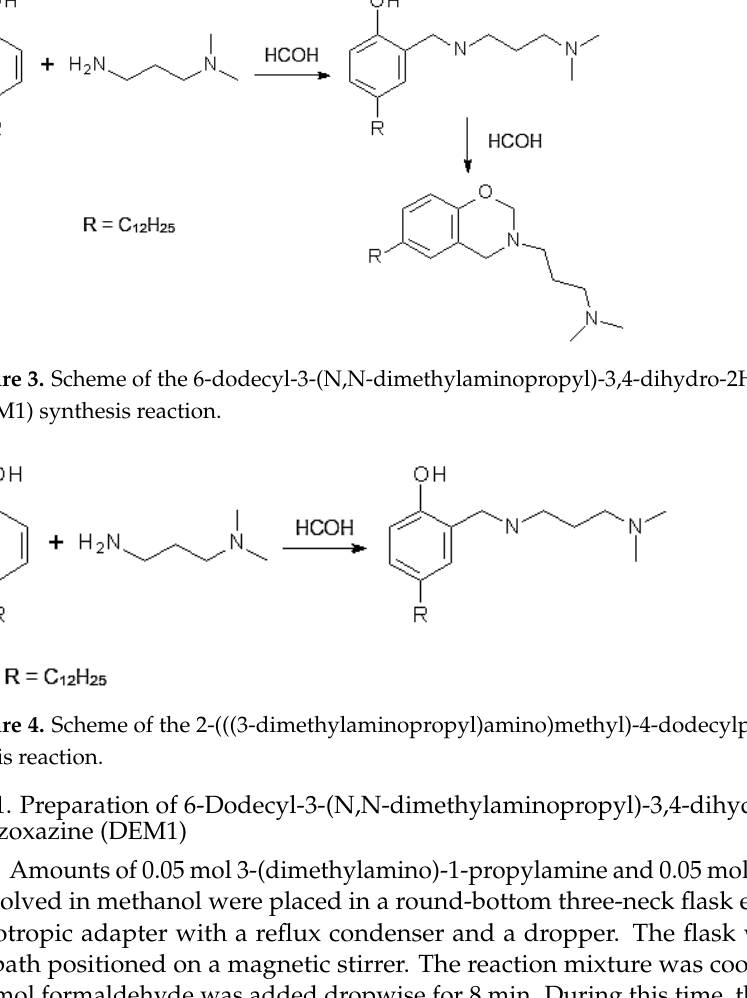
Table 2. Compositions of the developed additive batch formulations.